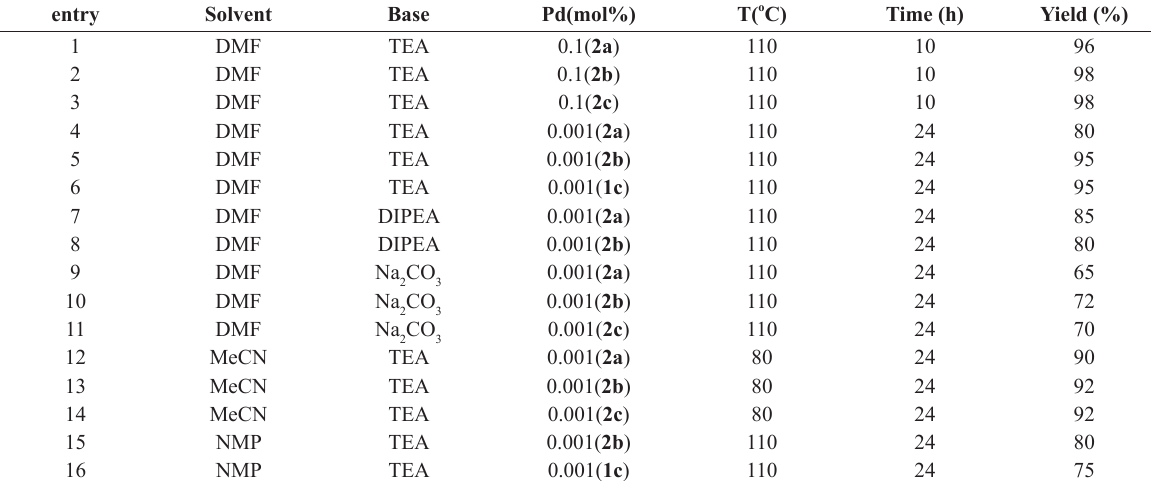
Yields and main conditions for reactions shown in Figure 4.